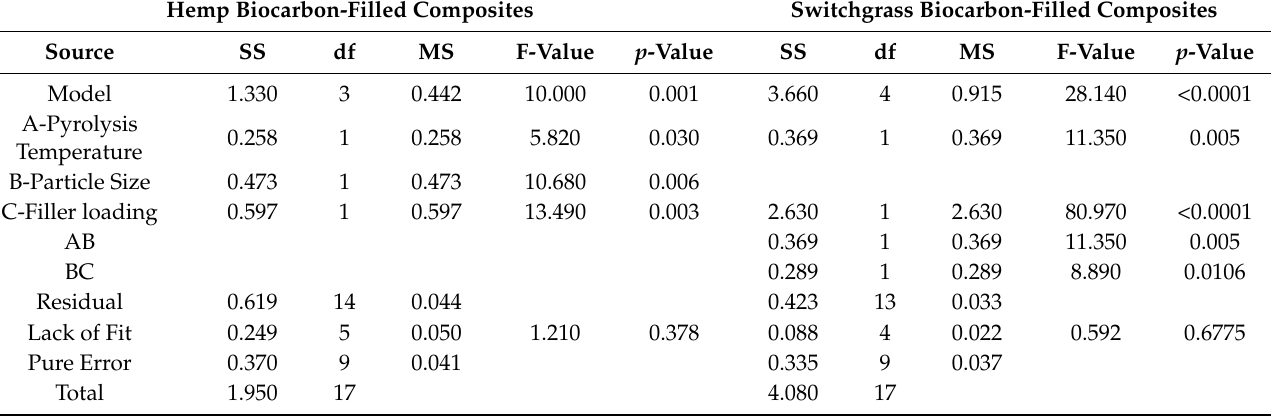
Table 4. ANOVA table for the Reduced Model for the Water Absorptivity as a Response of the Biocarbon-Filled Hemp